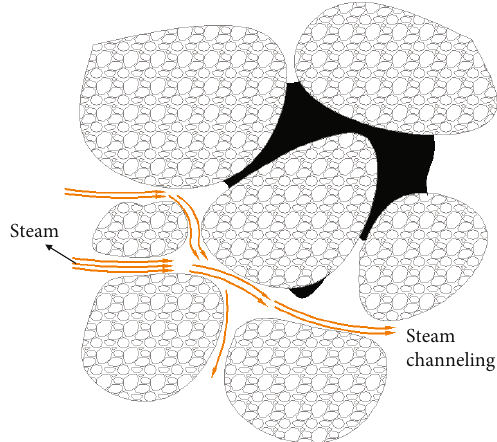
Figure 1: Schematic diagram of steam channeling.